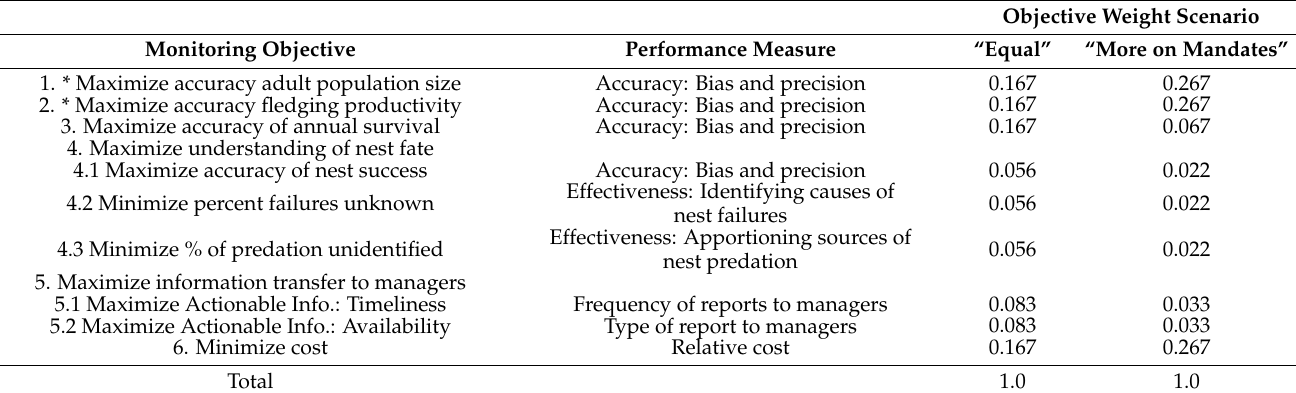
Table 1. Monitoring objectives, performance measures, and weights used to evaluate potential monitoring strategies. Monitoring objectives 1 and 2 are related to the recovery criteria * and are considered monitoring mandates; for the purposes of this analysis, cost was also considered a mandate. The “Equal” objective weight scenario places equal weight on the six fundamental monitoring objectives; “more on mandates” places 80% on recovery mandates (objectives 1, 2, and 6) and 20% on the remainder (objectives 3–5). Our performance measures are constructed scales to quantify the achievement of objectives; see Supplementary Materials 2 for details of the constructed scales.